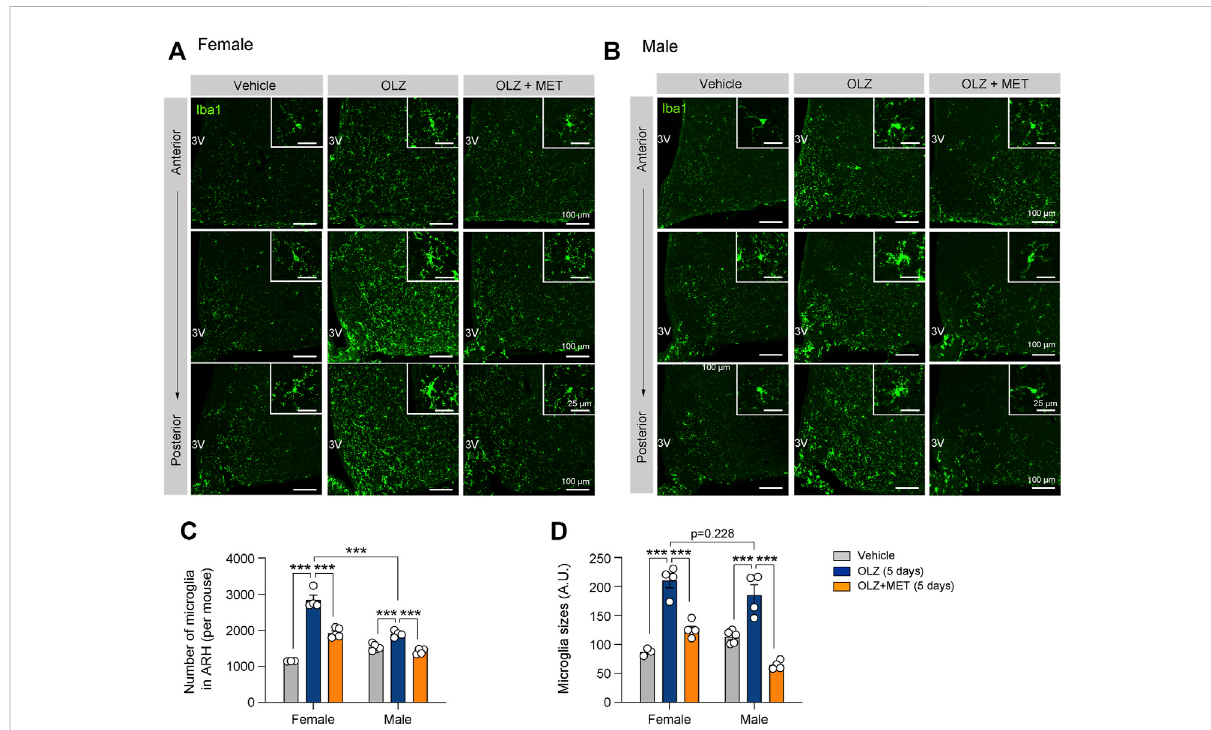
FIGURE 2 Metformin (MET) attenuates olanzapine (OLZ)-induced microglial activation in the hypothalamus. (A,B) Representative images of ionized calcium-binding adapter protein 1 (Iba1)-expressing microglia in the ARH of female and male mice that were administered OLZ or OLZ + MET for 5 days( n =3 – 5). (C,D) ThenumbersandsizesofIba1-expressingmicrogliaintheARHoffemaleandmalemicethatwereadministeredOLZorOLZ+ MET for 5 days ( n = 3 – 5). Data are presented as mean ± SEM values. Statistical analyses were performed using one-sided one-way analysis of variance (ANOVA) followed by a post hoc least signi fi cant difference (LSD) test. *** p < 0.001 between the indicated groups. Scale bars: 100 μ